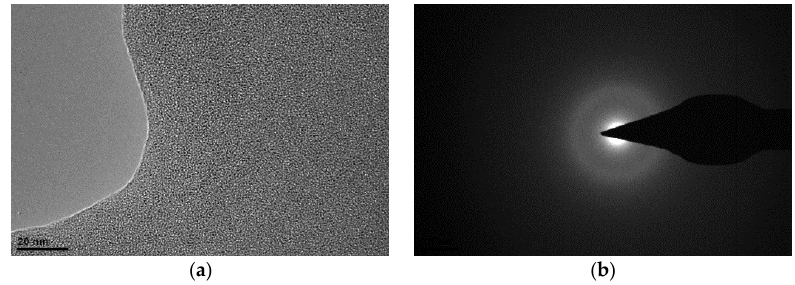
Figure 8. TEM micrograph showing the nanostructure and diffraction pattern of a fiber core produced by granulated silica derived from the sol-gel process [8]. ( a ): Bright field image; ( b ): Diffraction pattern.